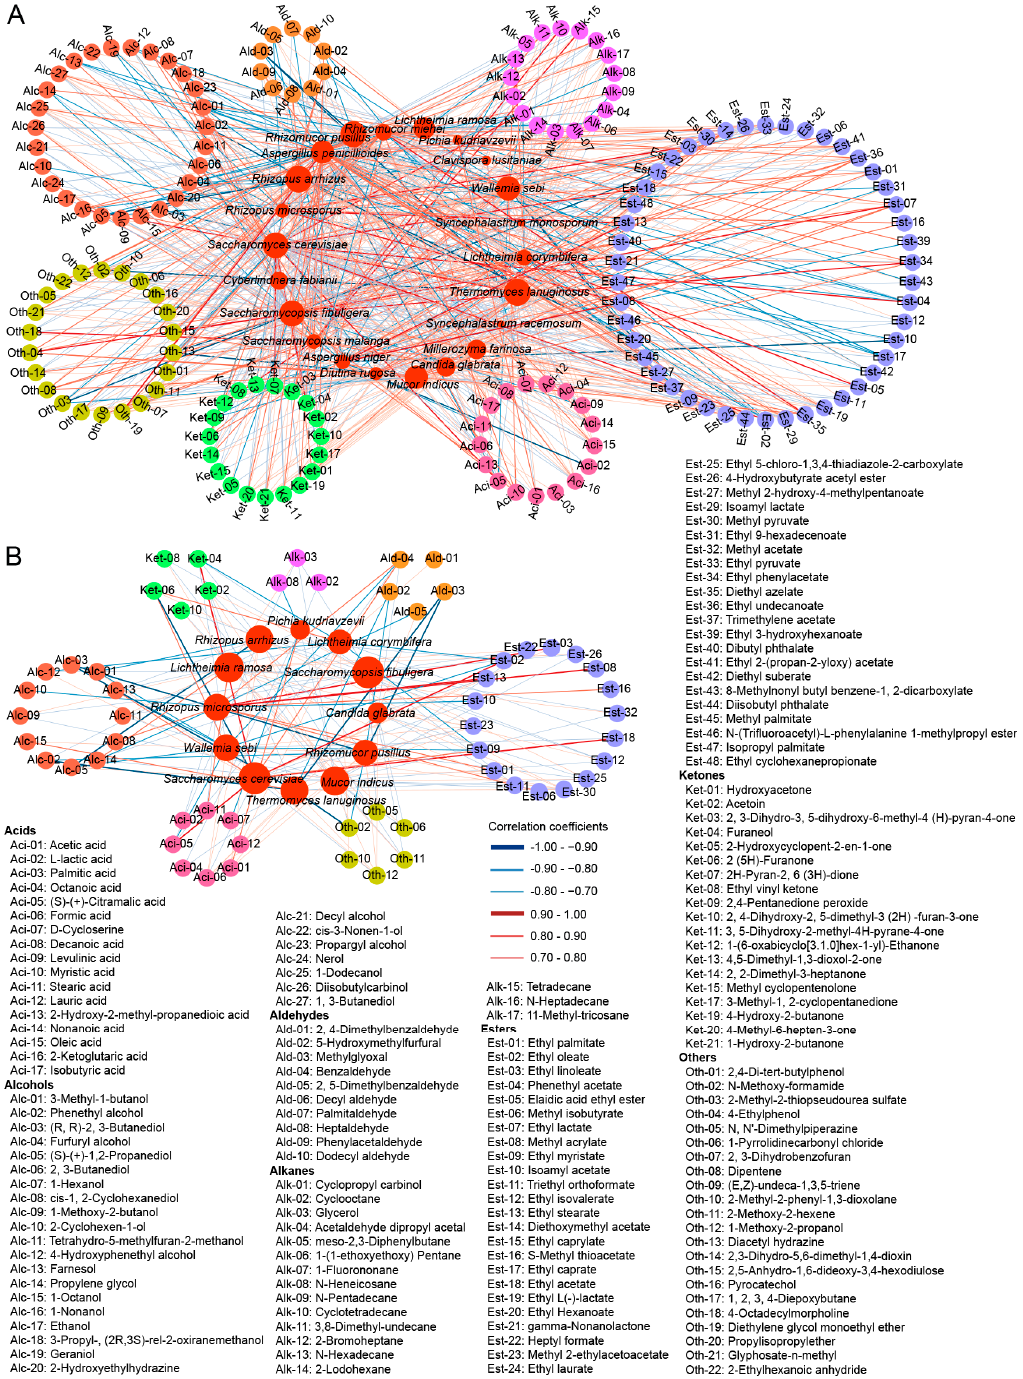
Figure 7. Visualization of the correlation network according to significant correlations between fungal species and volatile compounds in corresponding rice wine samples. ( A ) All fungal species and volatile compounds; ( B ) fungal biomarkers and important volatile compounds (VIP > 1.00). Only significant edges are drawn in the network using the Spearman’s correlation test (|r| ≥ 0.7 with p < 0.05). The size of the nodes representing fungi (red circle) indicates the size of degree value.